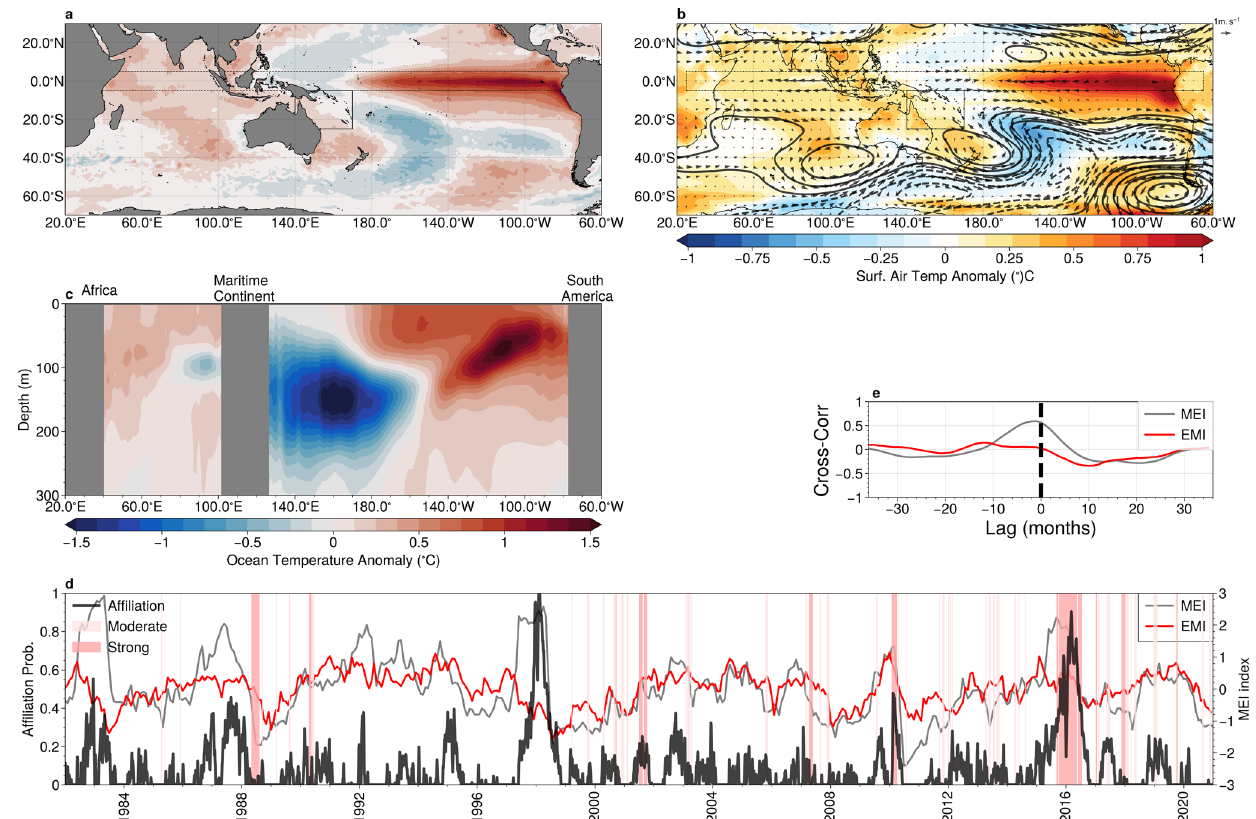
Fig.8|Teleconnectionsassociatedwithmarineheatwavesinthecoralseaand great barrier reef. a Sea-surface temperature (SST) anomaly; b surface air tem- perature(colours)withanomalousmid-tropospheric(500hPa)geopotentialheight (contour lines, contour interval 5m) and winds (vectors); and c subsurface ocean temperatures (averaged latitudinaly between 5°S and 5°N within the region indi- cated by dashed lines in panels a and b ), associated with archetype #4; d The